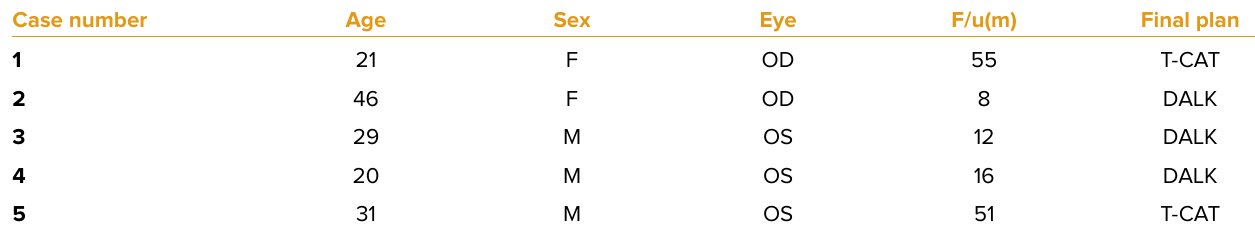
Table 1. Demographics and follow up time Case number